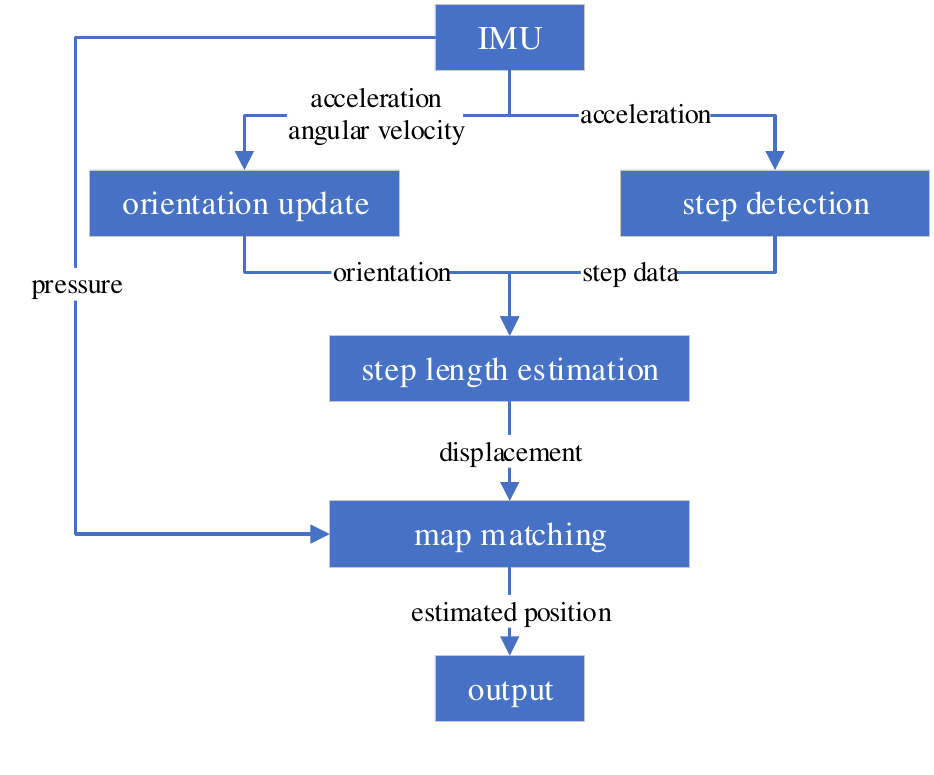
Figure 2. System